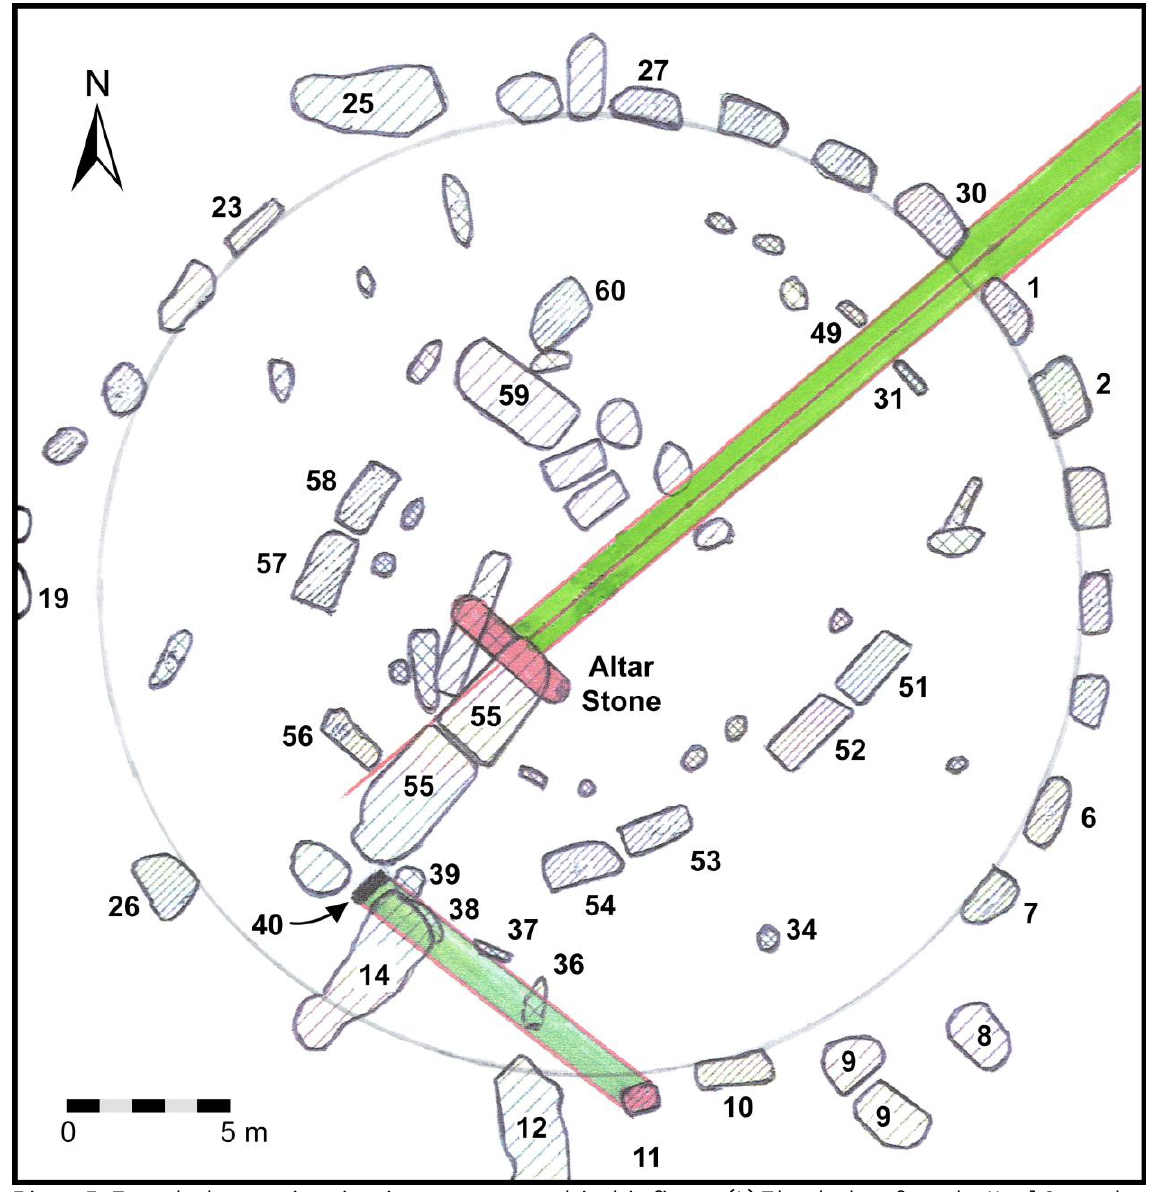
Figure 7. Two shadow casting situations are suggested in this figure. (1) The shadow from the Heel Stone that reaches the recumbent Altar Stone at midsummer sunrise; (2) the shadow from the short squat Stone 11 (at the south in this plan) with its winter solstice sunrise alignment to a stone at or near the present position of broken Bluestone 40 (shown black). Notice that the long recumbent Altar Stone is parallel to the latter line, and not at right angles to the midsummer sunrise axis of Stonehenge. The same applies to the Great Trilithon Stone 56. (Author’s diagram, after Cleal et al. 1995: 27) with the discussed shadows